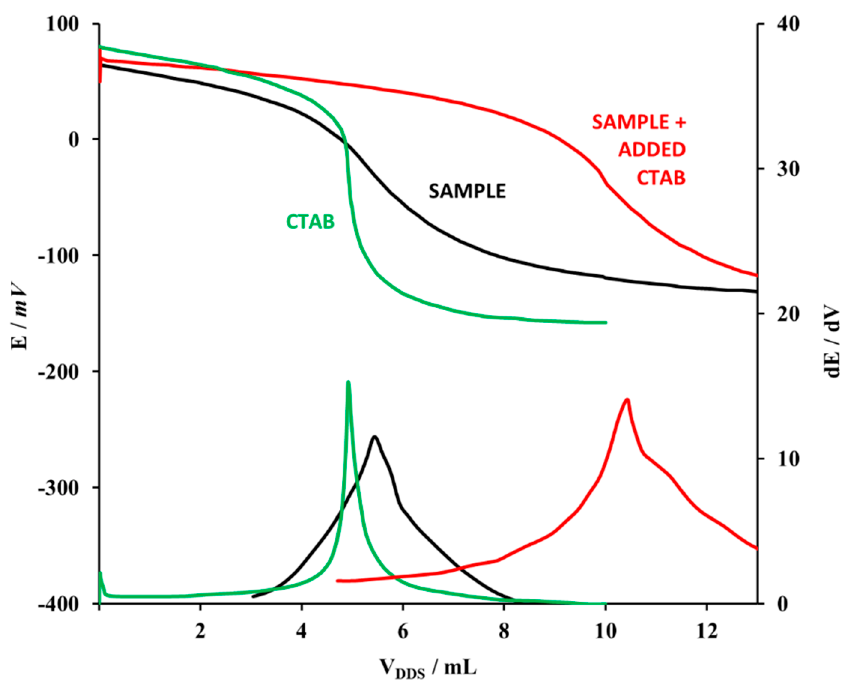
Figure 4. Direct potentiometric titration curves of (1) the commercial sample of the mouthwash 3 (black line); (2) CTAB (5 × 10 − 4 M) sample (green line); and (3) the same sample of mouthwash 3 with known addition of CTAB (red line); and their corresponding first derivatives. DDS (5 × 10 − 4 M) was used as the titrant.